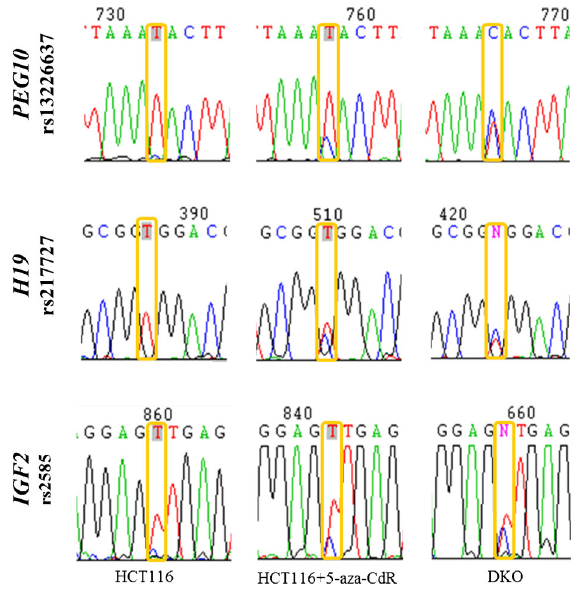
Figure 3. Expression pattern of the selected imprinted genes in the HCT116 cell line after 5-aza-2 9 -deoxycytidine (5-aza-CdR) treatment. Electropherograms of cDNA sequences of PEG10 , H19 and IGF2 genes show the biallelic expression. Symbols of genes and corresponding single nucleotide polymorphism (SNP) ID are indicated at the side. SNP positions are highlighted in